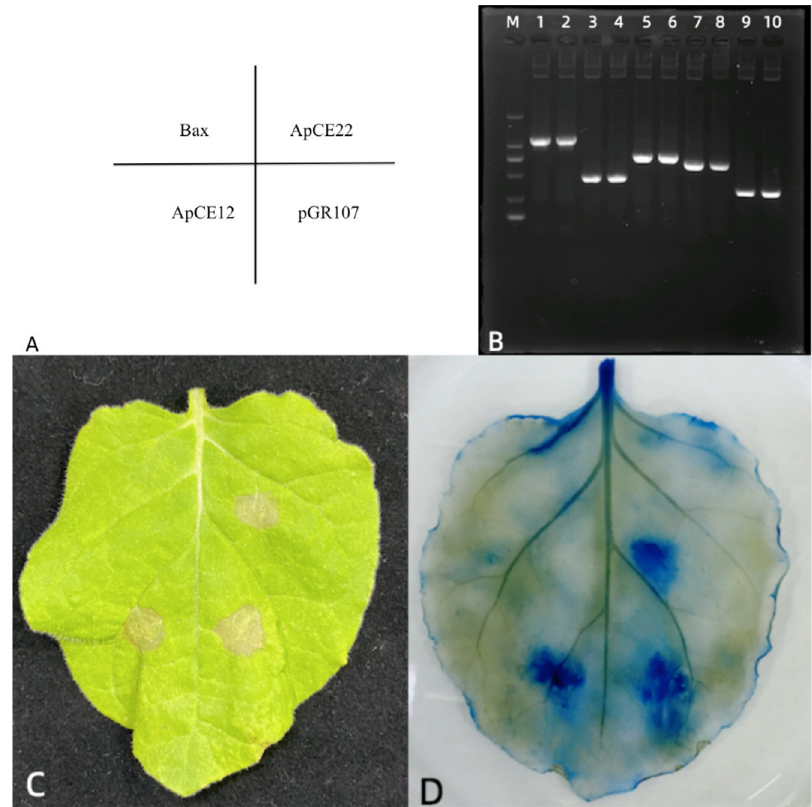
Figure 10. Transient expression results of effectors ApCE12 and ApCE22 in tobacco. Note: ( A ): Location map of tobacco leaf inoculation; ( B ): RT-PCR results of tobacco leaves inoculated with effectors; M: DL 2000 DNA marker; 1, 2: Tobacco Actin; 3, 4: ApCE12 ; 5, 6: ApCE22 ; 7, 8: Bax; 9, 10: pGR-107. ( C ): Effectors ApCE12 and ApCE 22 transient expression symptoms in tobacco. ( D ): Symptom of tobacco after trypan blue staining.